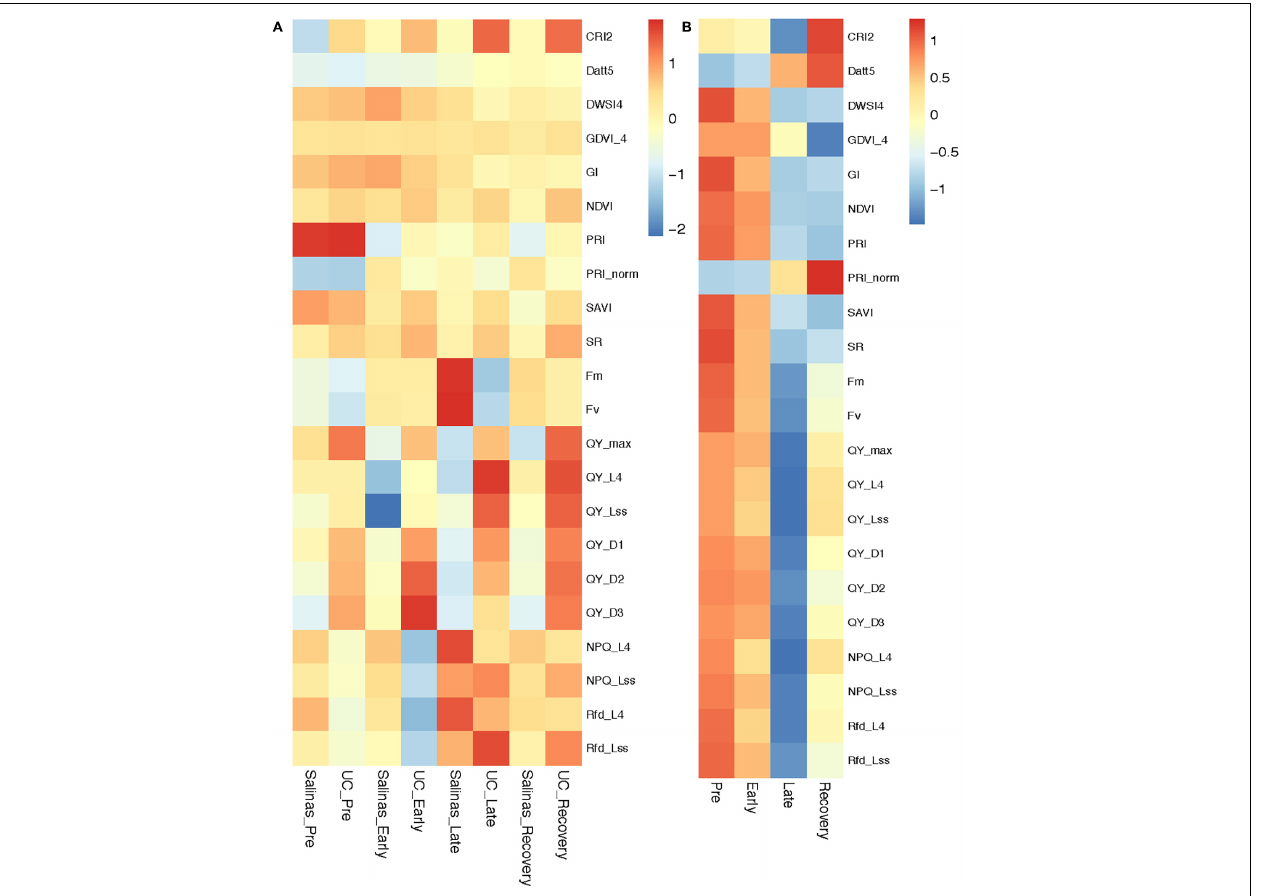
FIGURE 3 | Heatmap depicting changes in chlorophyll fluorescence parameters and vegetation indices during water-stress progression and recovery. (A) Mapping parents, (B) Recombinant inbred line (RIL)